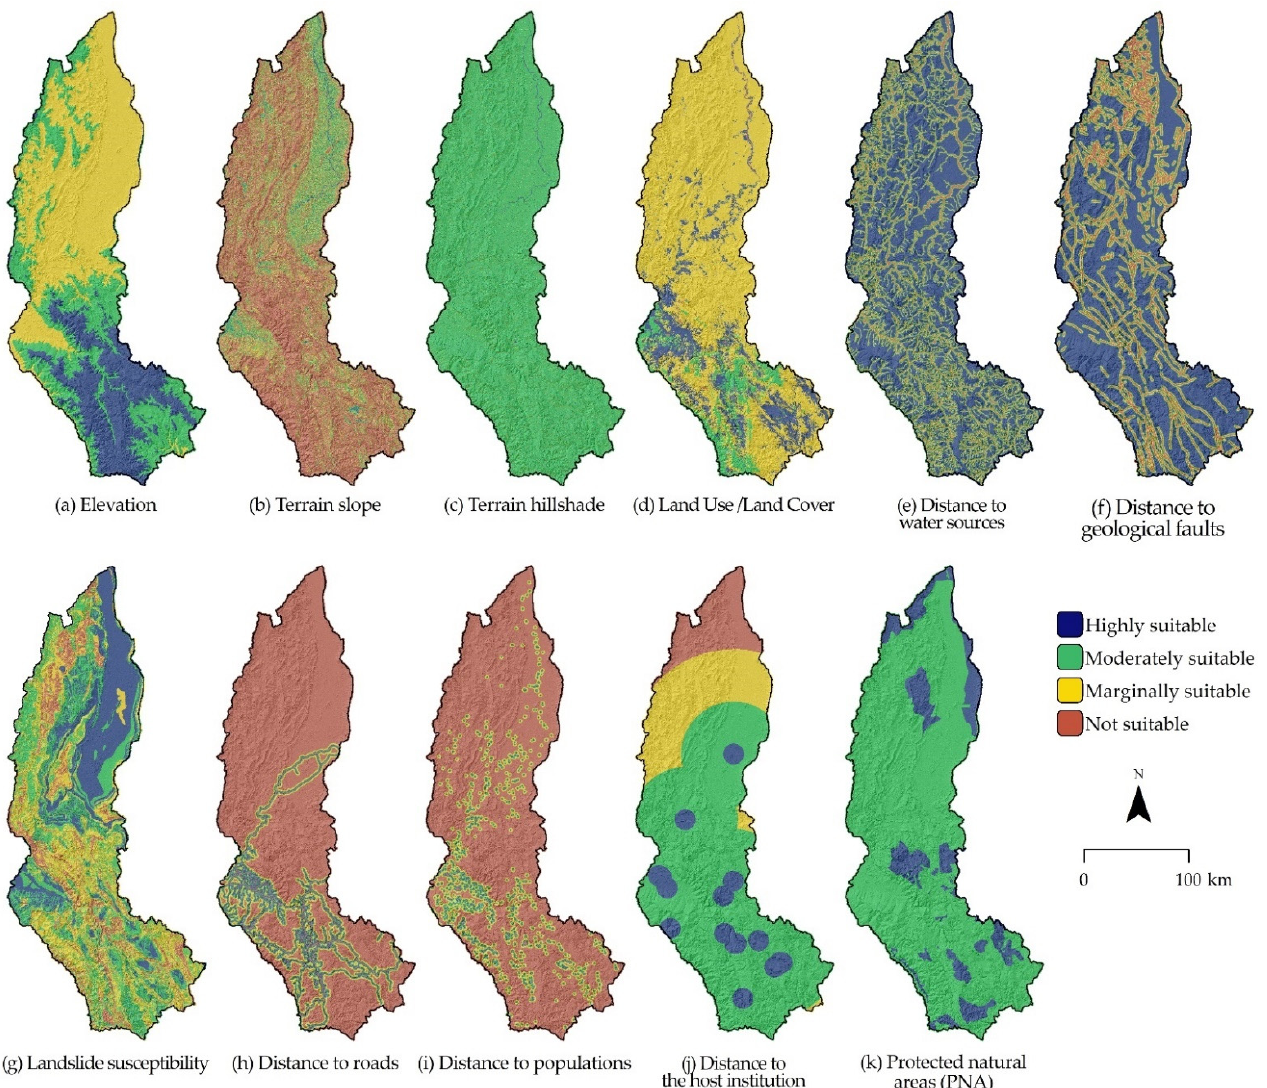
Figure 4. Suitability maps of the biophysical ( a – g ) and administrative ( h – k ) sub-criteria for selecting locations for weather stations in Amazonas, NW Peru.